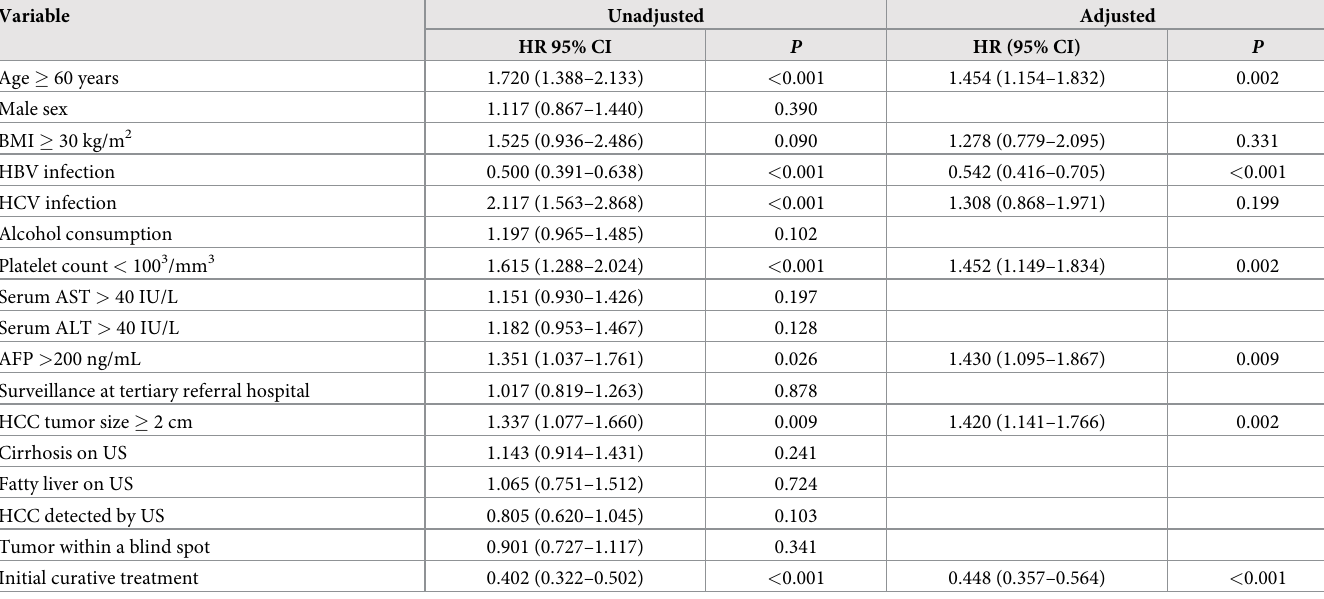
Table 5. Factors associated with overall survival in patients with single-nodular HCC detected during US surveillance. Variable Unadjusted